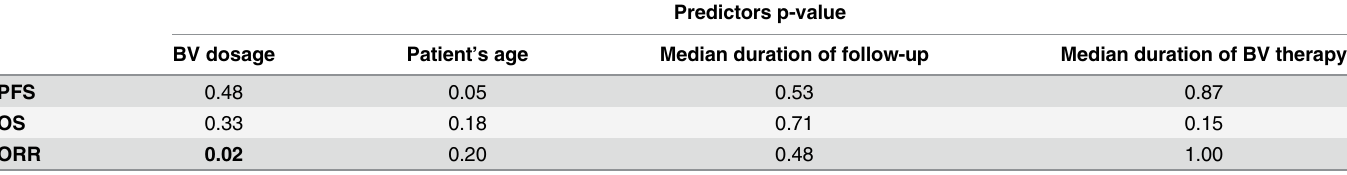
Table 5. Meta-regression